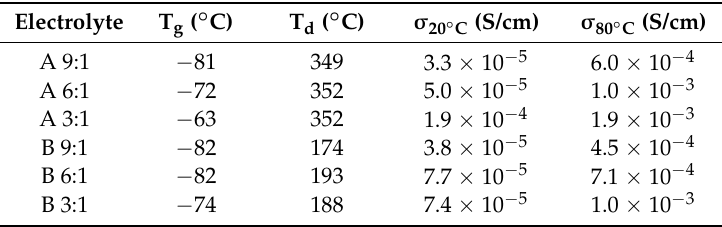
Table 1. Glass transitions, decomposition temperatures, and ionic conductivities at 20 and 80 ◦ C.